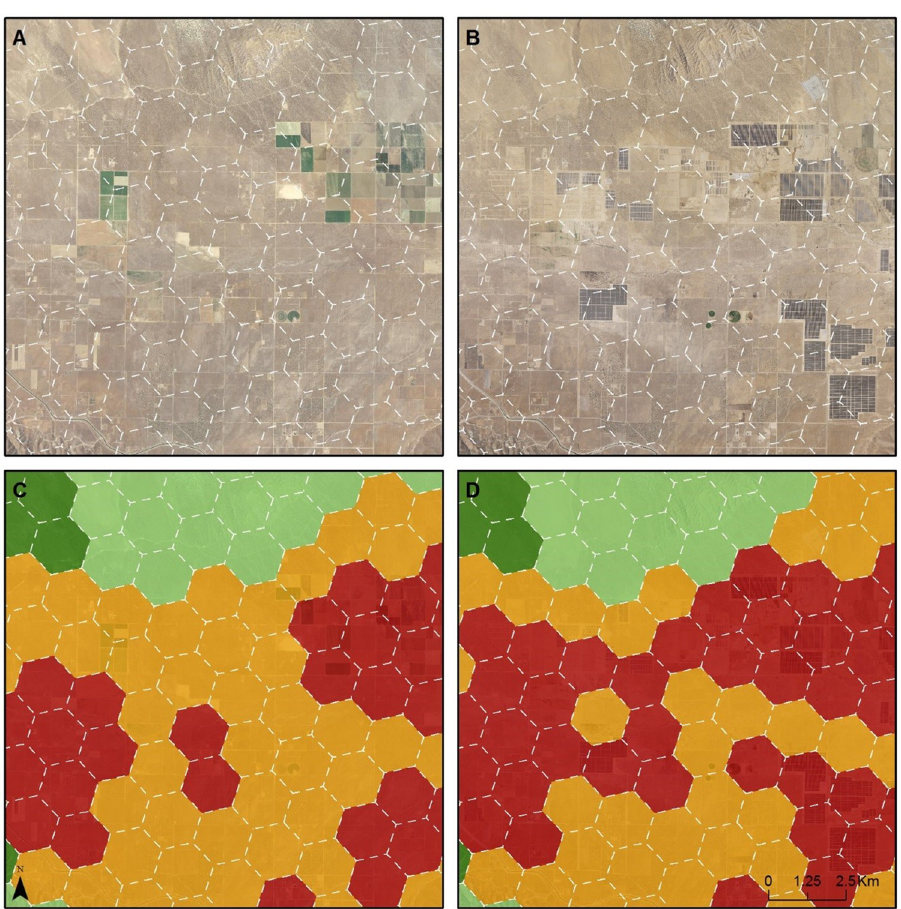
Fig 5. One example of change in conservation value in Western Mojave due to solar energy development. A: 2009 imagery; B: 2016 imagery; C: Conservation Value in 2009; D: Conservation Value in 2017. The four colors shown on maps C and D (dark green, light green, orange, and red) correspond with the conservation value categories defined in Table 2.